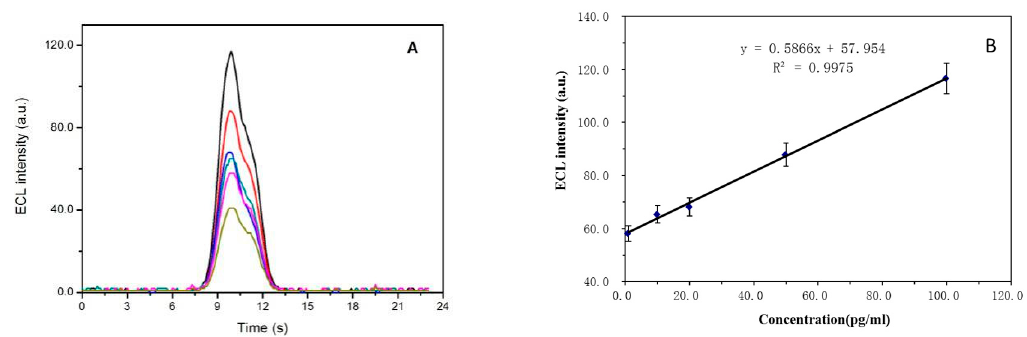
Figure 8. ( A ) ECL intensities of the detected immune complex of the antigen HBsAg at the concentrations of 0.0, 1.0, 10.0, 20.0, 50.0 and 100.0 pg mL − 1 in the detecting system and ( B ) the corresponding linear relationship between the concentrations of the detected HBsAg and their ECL maximum intensities (n = 3, mean + SD).